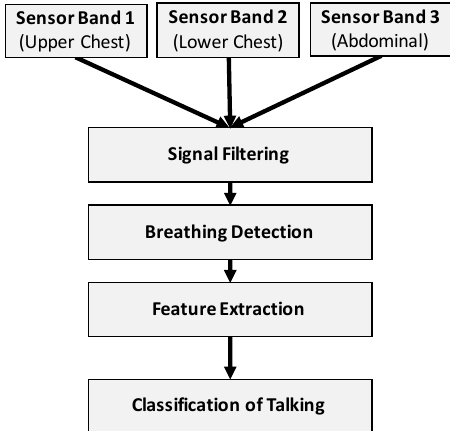
Figure 4. Design of the talking detection algorithm incorporating machine